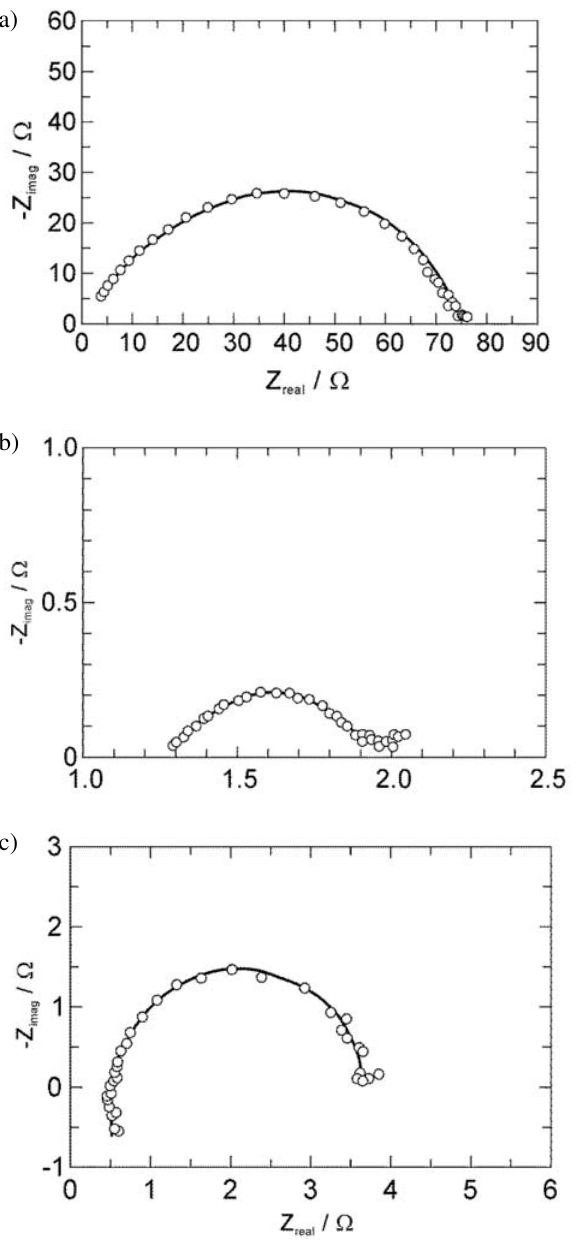
Figure 3. Examples of Impedance spectra measured 1 day after ex- posure of the Li to the catholyte. a) A-catholyte – cell G40A, b) B-catholyte – cell G24B, and c) SO -catholyte – cell SO21. Expo- 2 sed Li area is 25 cm 2 in all three cases. For further details, see Tab- le 1 and the text.